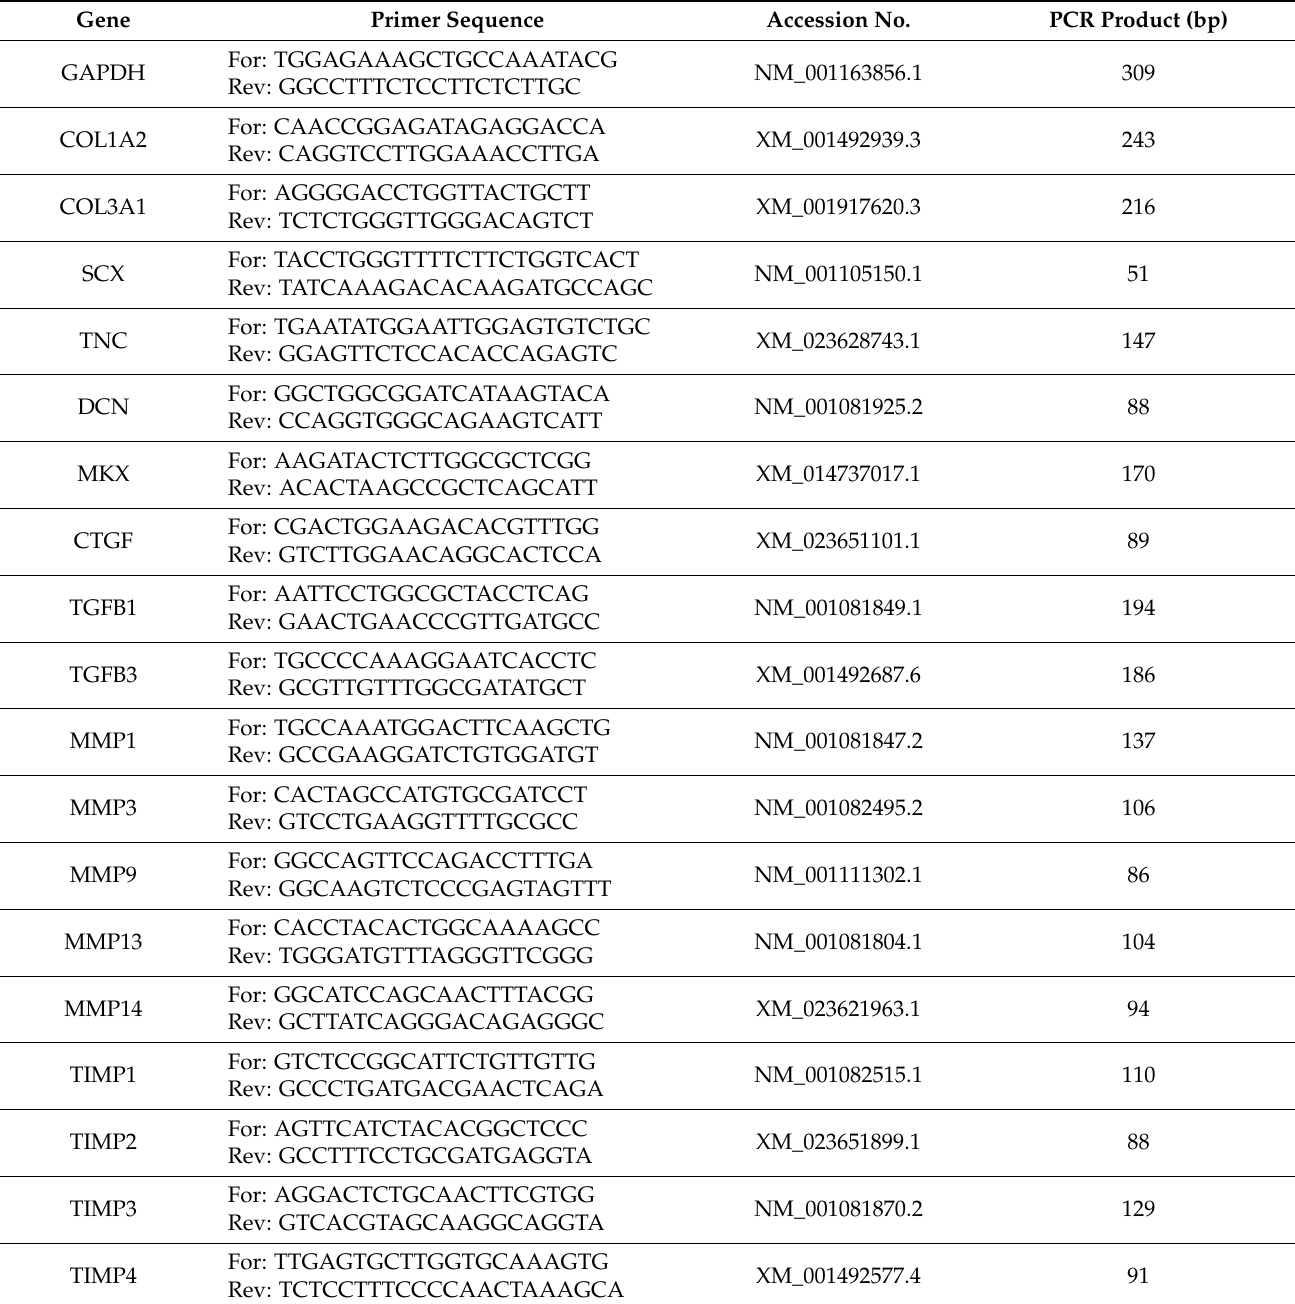
Table 1. Primer sequences used for